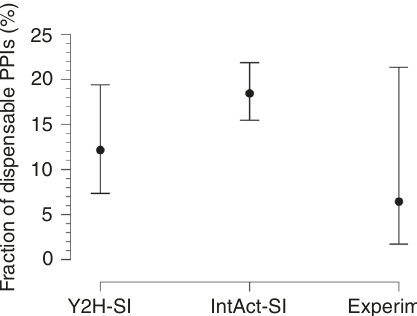
Fig. 3 Dispensable PPI content estimated from geometry-based